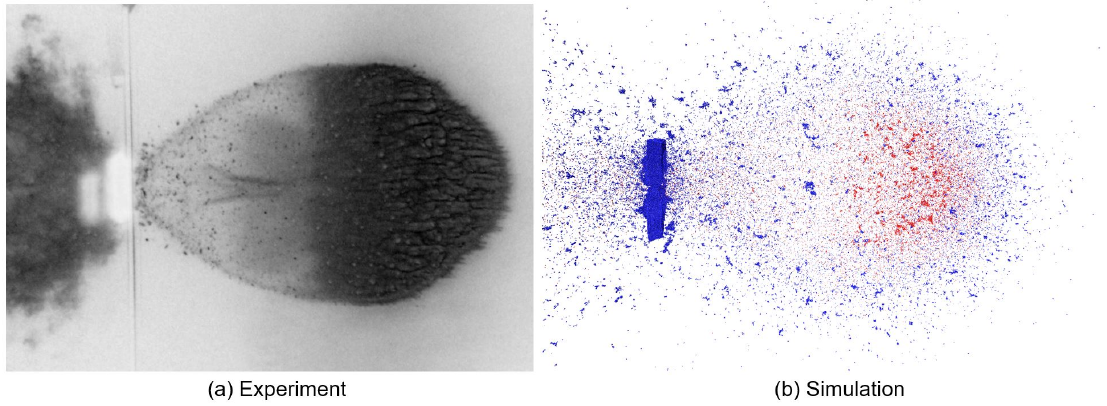
Figure 14. Simulations with high t / D ratios match the experiment closely with complete fragmentation of the impactor and a similar cloud shape. ( a ) High-speed photograph of experiment (intensity inverted); ( b ) 3D simulation shown with v 0 = 6.7 kms − 1 and t / D =